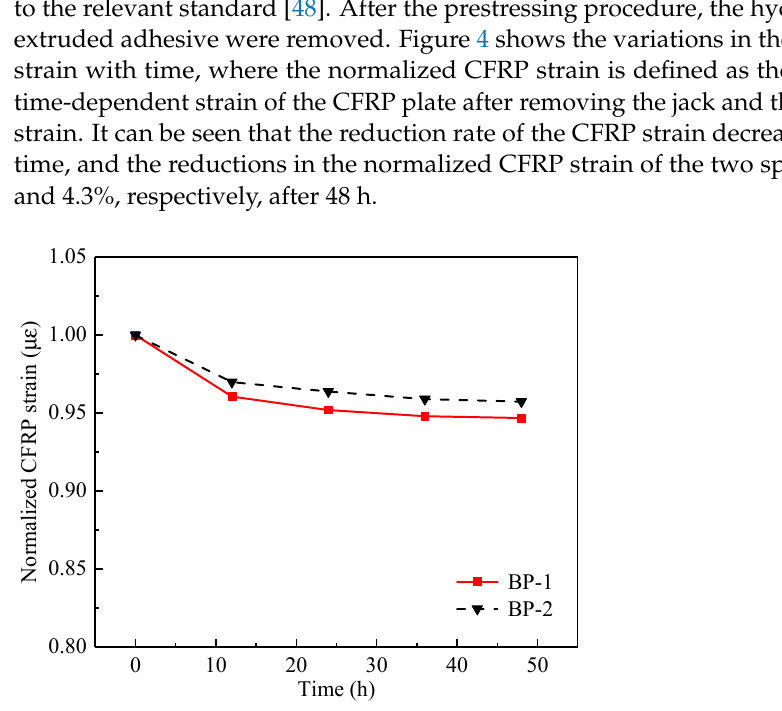
Figure 3. Prestressing systems used in the tests: ( a ) adhesive-friction anchor and ( b ) wedge-clamp anchor.